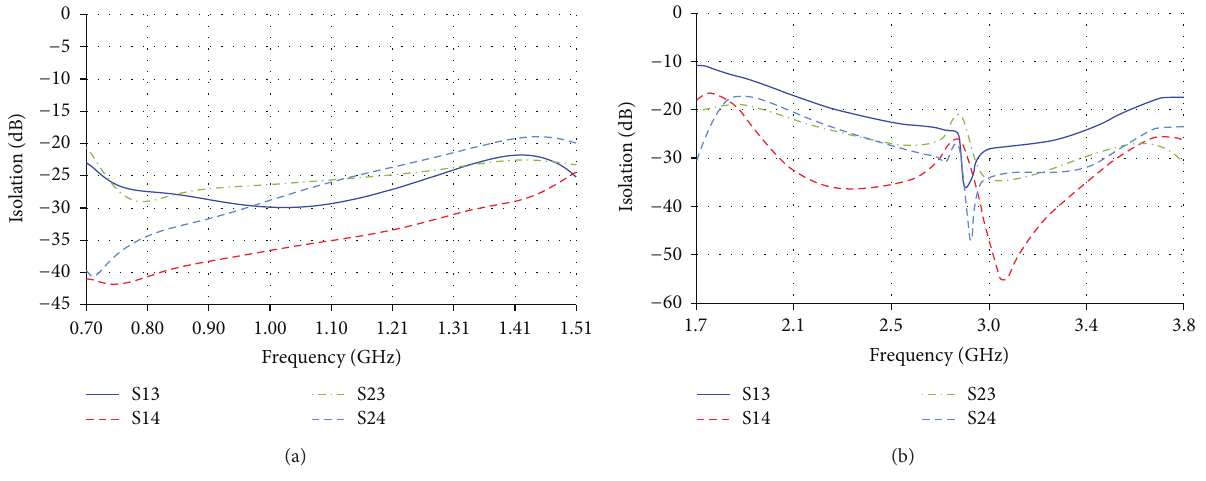
Figure 13: Isolation between each of low band and high band antennas in (a) the low frequency band and (b) the high frequency band on smart